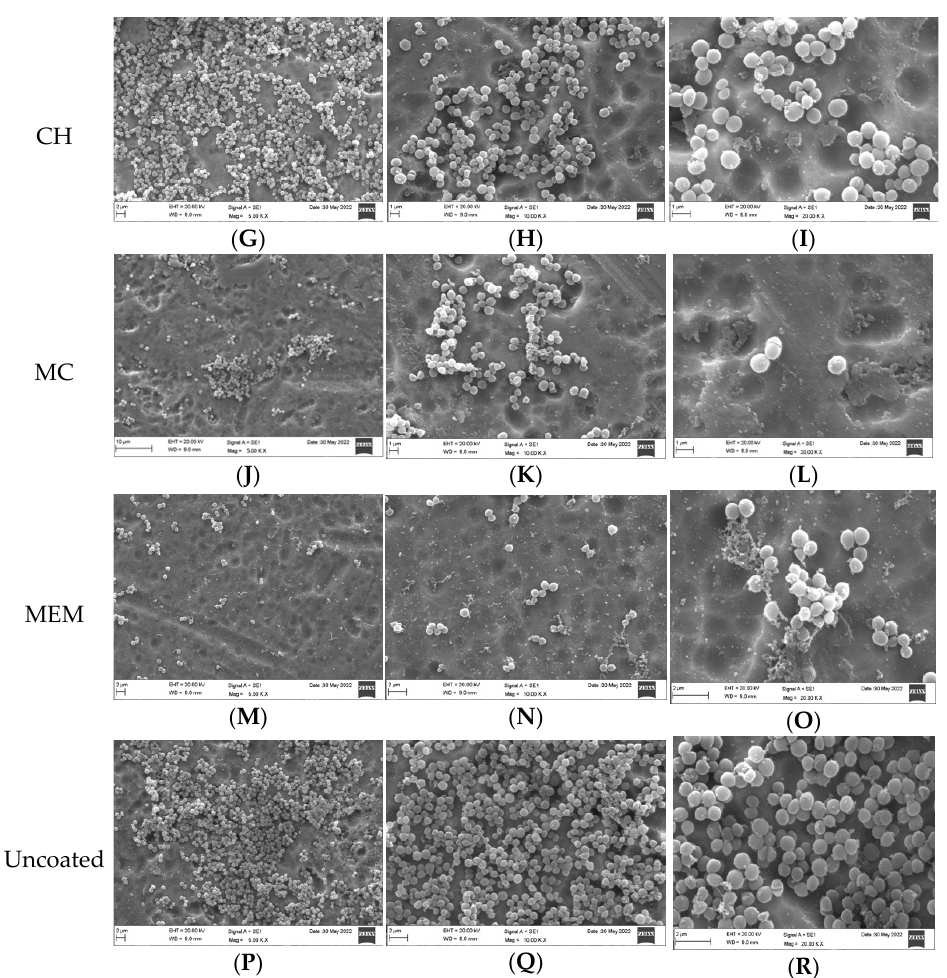
Figure 2. SEM appearance of coated plates with SA bacteria including the negative control. At 5, 10 and 20 k magnification.